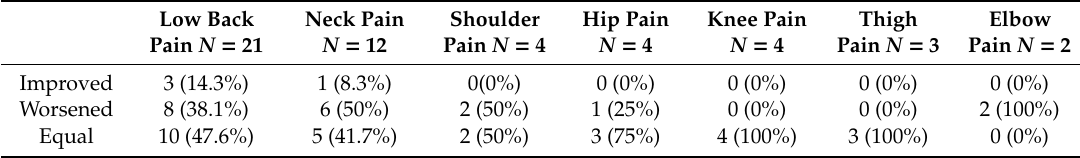
Table 6. Impact of home working on musculoskeletal disorders (Total =